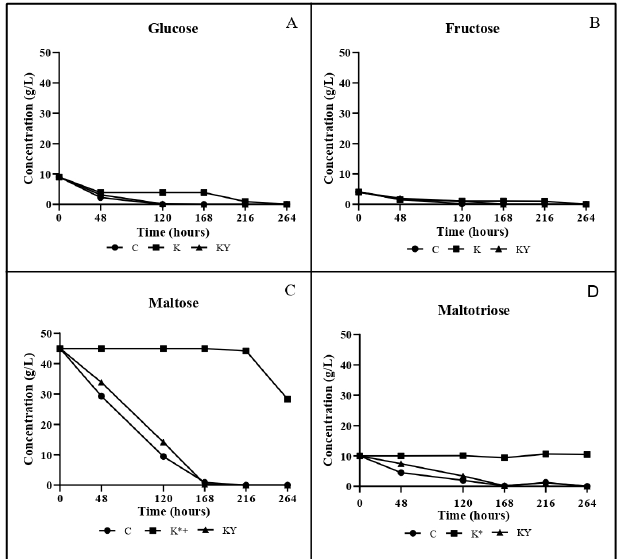
Figure 1. Concentrations (g/L) of glucose ( A ), fructose ( B ), maltose ( C ) and maltotriose ( D ) during the 264 h of fermentation for the C, K and KY assays. C: control, K: kombucha, KY: kombucha + commercial brewer yeast. *, Significant difference ( p < 0.05) between C and K assays; +, significant difference ( p < 0.05) between K and KY assays.